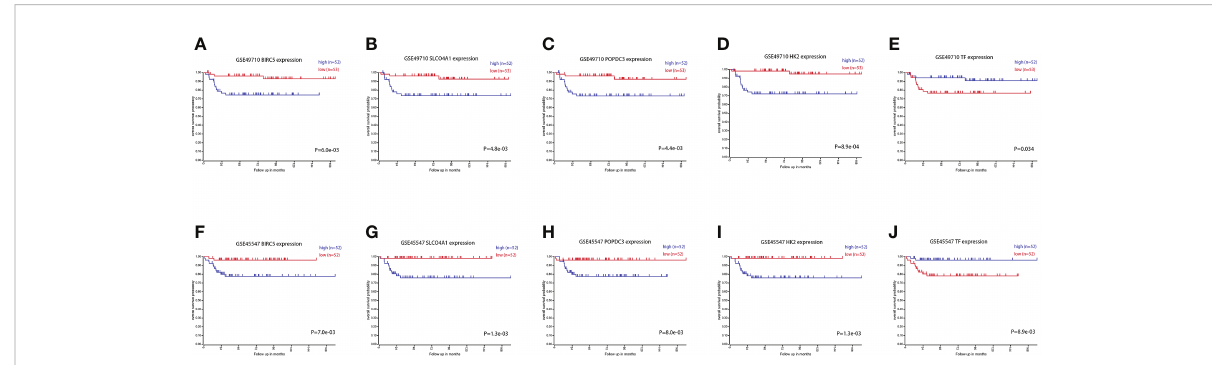
FIGURE 4 Survival curves of patients grouped by BIRC5, SLCO4A1, POPDC3, HK2 and TF expression in the two datasets. (A – E) The prognostic value of BIRC5, SLCO4A1, POPDC3, HK2 and TF in the GSE49710 dataset. (F – J) The prognostic value of BIRC5, SLCO4A1, POPDC3, HK2 and TF in the GSE45547 dataset. Gene expression levels are grouped by